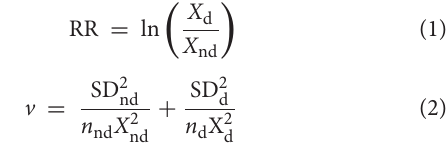
least one of the soil property and microbial variables ( Figure 2